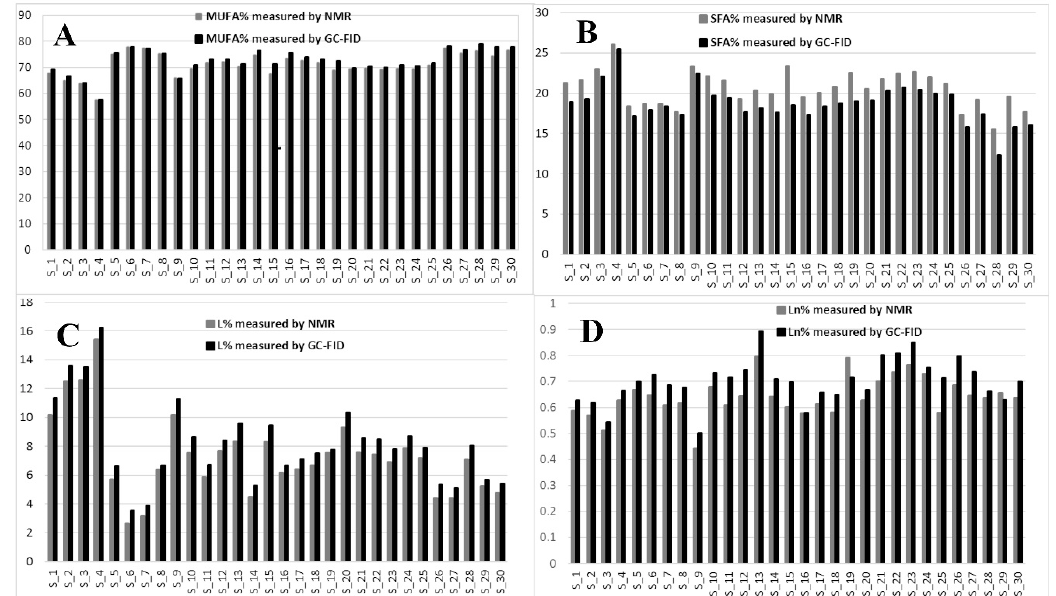
Figure 4. Comparison between MARA-NMR and GC-FID measured quantitative parameters referred to: ( A ) mono-unsaturated (MUFA), ( B ) saturated (SFA), ( C ) Linoleic (L) and ( D ) Linolenic (Ln) esters in relative percent ratio.